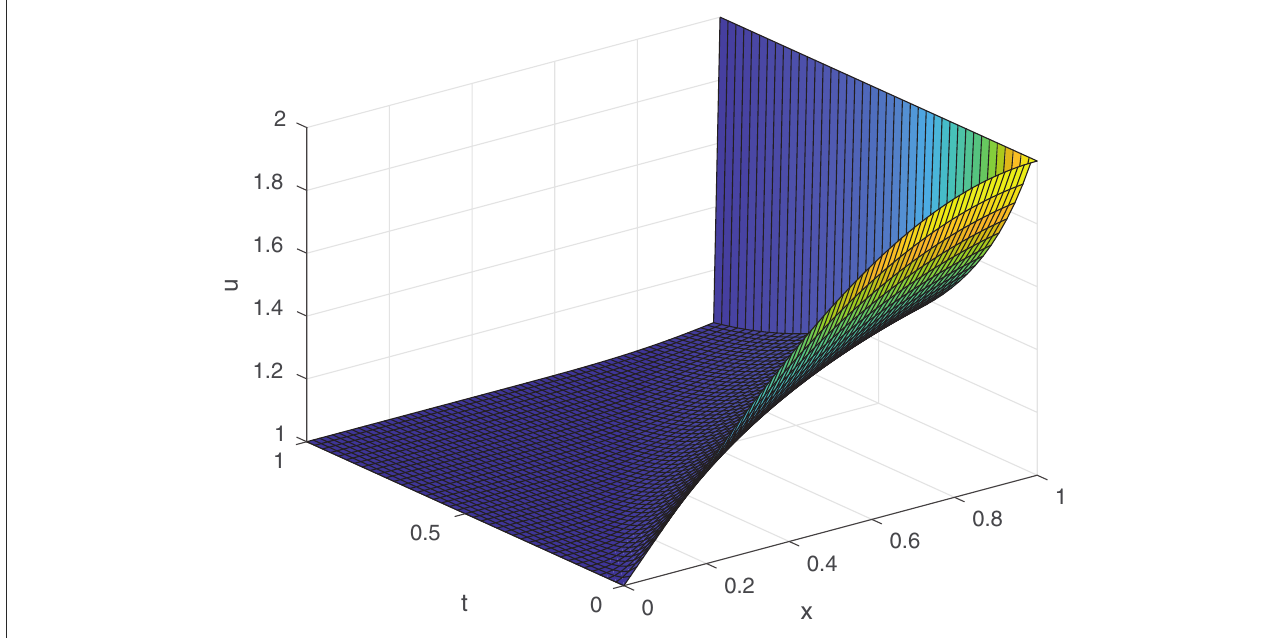
FIGURE2 Numerical solutions of Example 4.2 using the proposed method for T = 1, M = 64, N = 40 and ε = 10 − 4 . A layer is observed near x =